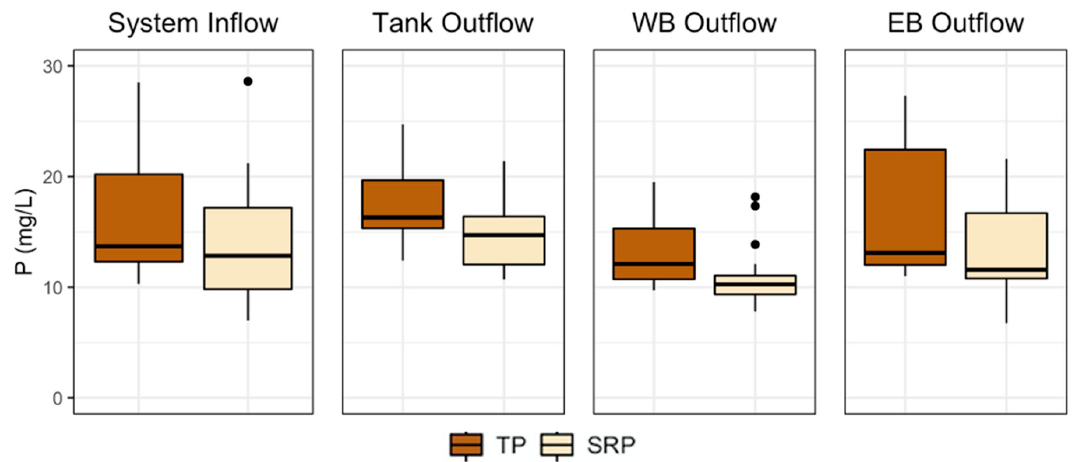
Figure 5. Box and whisker plots of phosphorus (P) species concentrations from each sampling location. Bottom and top boxes indicate 25th and 75th percentiles, respectively, the middle line shows the median, whiskers show the min and max, and points denote any outliers. TP = total P, SRP = soluble reactive P.